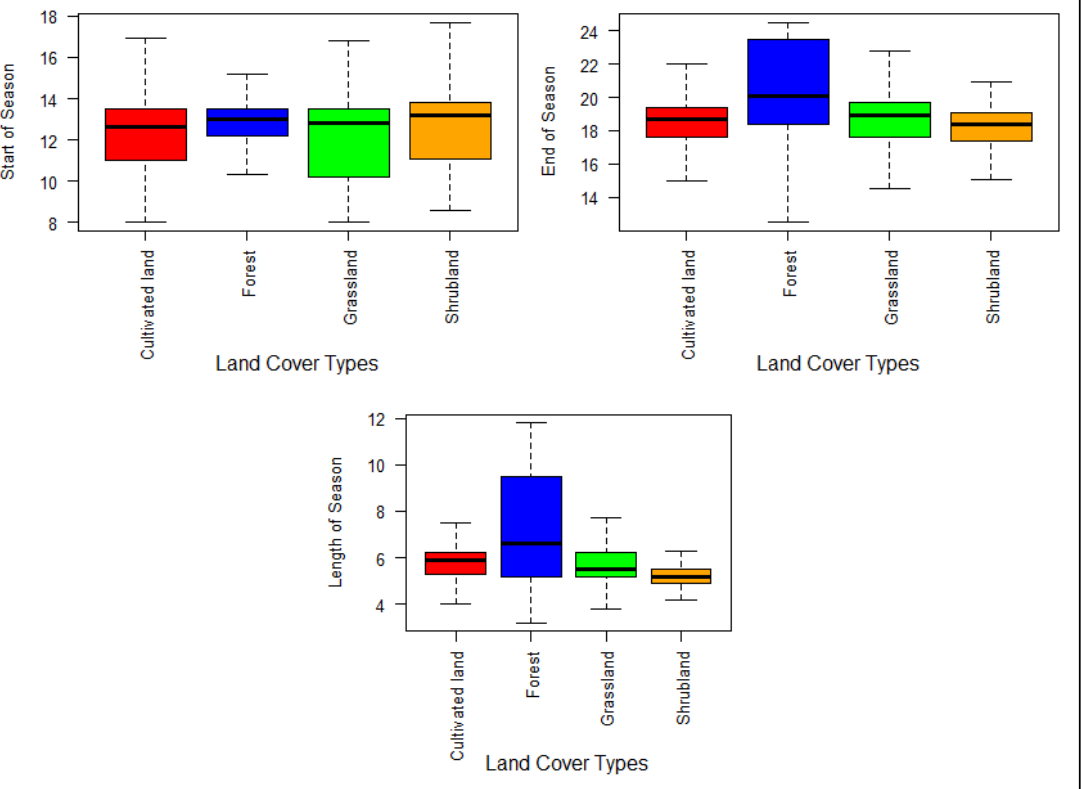
Figure 7. Box plots illustrating the distribution of SOS, EOS, and LOS for the four major land cover types across the Middle East.